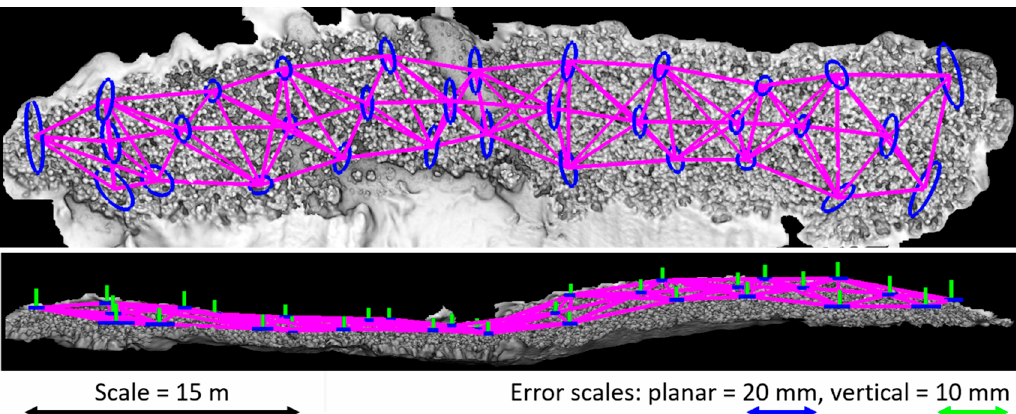
Figure 4. Graph of the primary control network for the 50 × 10 m fore reef plot: the point-to-point linking measurements (magenta), the horizontal error ellipses (blue) and the vertical error component (green).